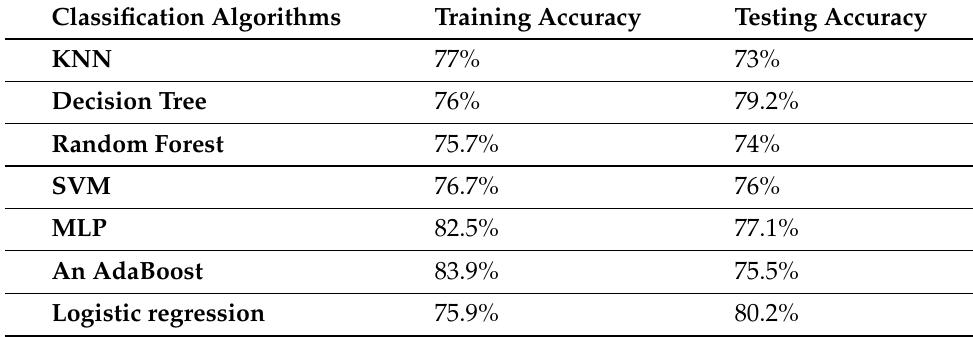
Table 2. The classification algorithms accuracy using 80% training and 20% testing dataset.